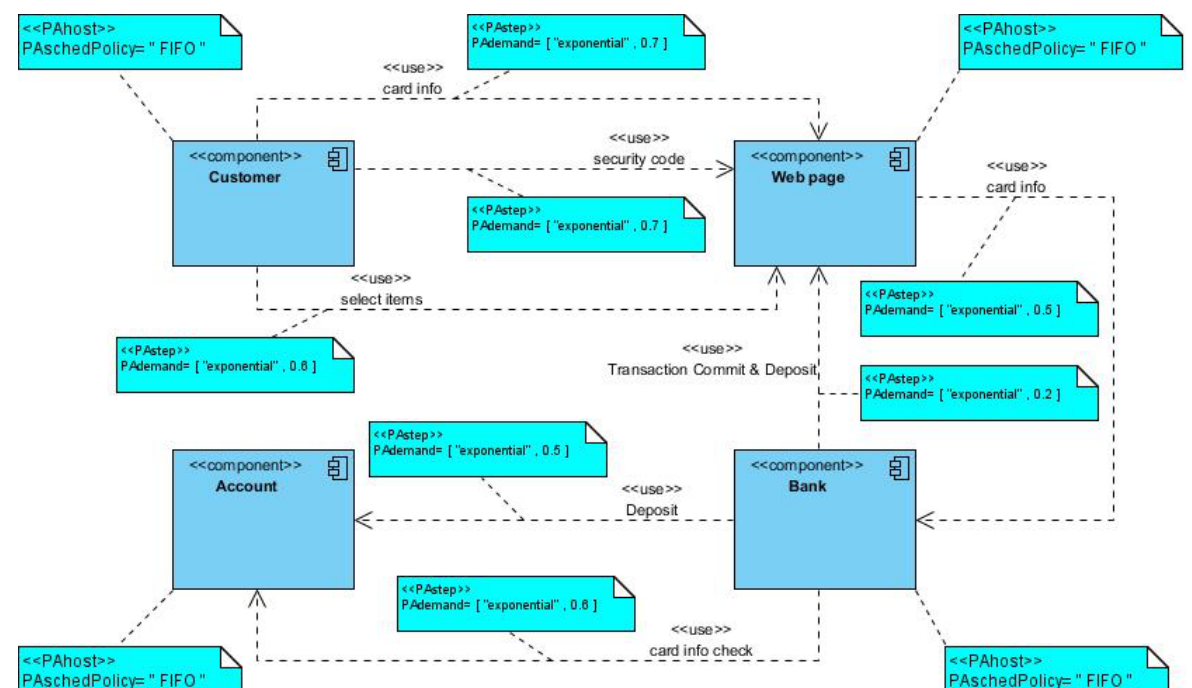
Fig. 7. The component diagram together with the efficiency information pertaining to the online shopping